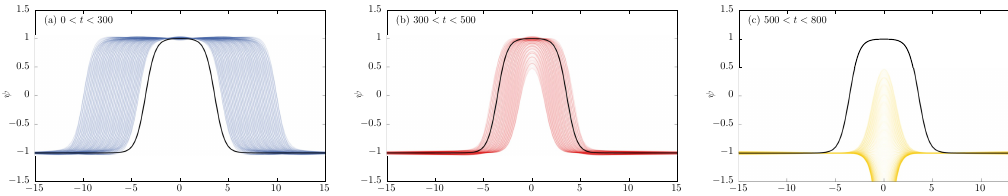
Figure 6 . Evolution of the field ψ obtained in the scattering of the initial configuration (5.1)–(5.2) with the pink mode ( n = 8) initially excited. Here A = 0 . 04 and solitons pass the SW.